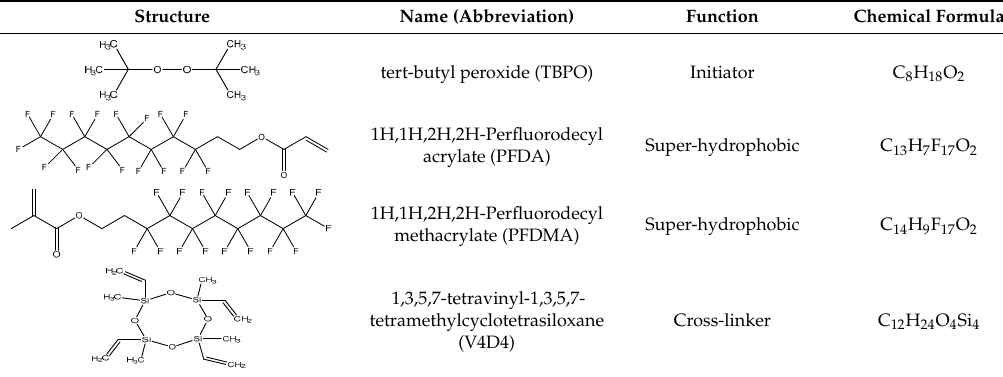
Table 1. Chemical structures and functions of the initiator and the monomers. Structure